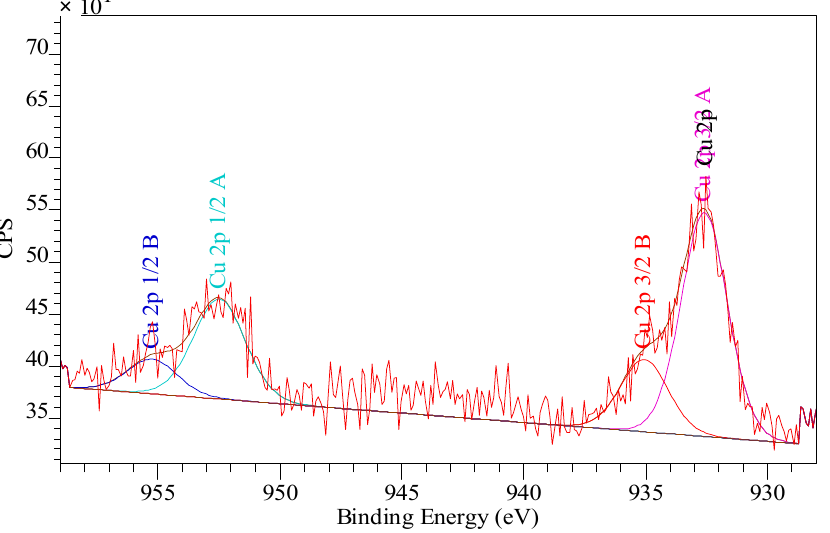
Figure 9. XPS spectrum obtained in a narrow range of binding energy made for Dowex M 4195 after the Cu(II) sorption.